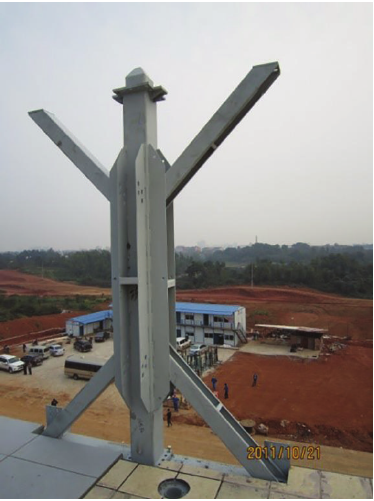
Figure 3: Inclined brace